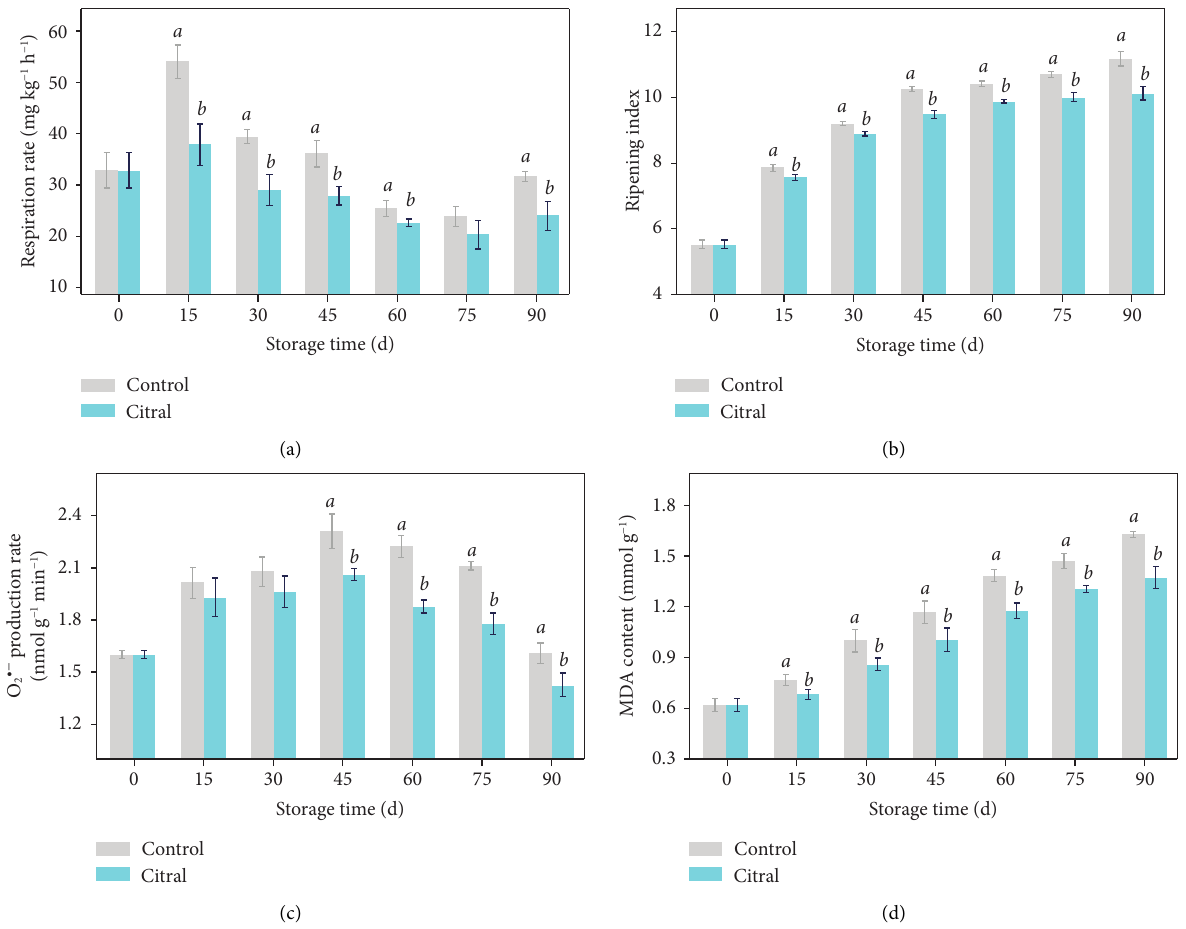
• − production rate, (c) and MDA content (d) of harvested 2